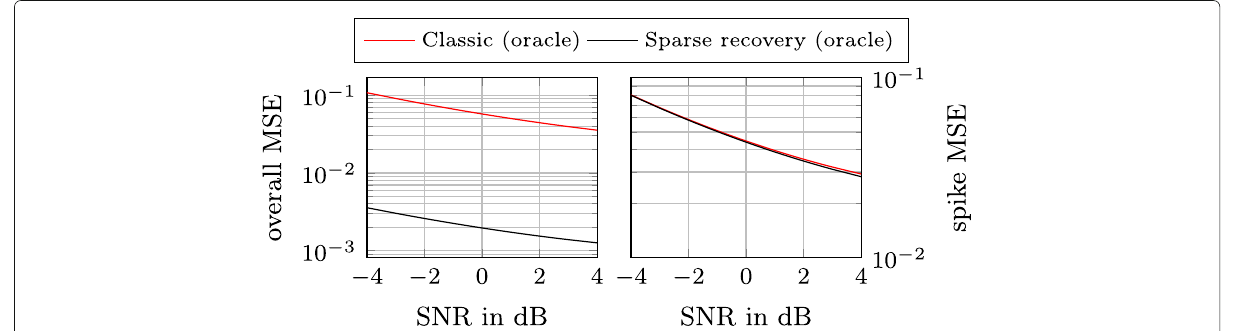
Fig. 5 MSE between the CAF estimation and the actual (analytic) value. Left over the whole support, right at the cycle frequencies. Both at consecutive sample ratio 0.15